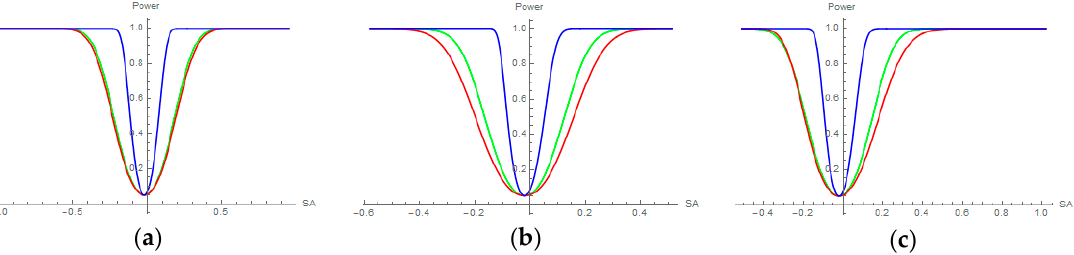
Figure A11. Statistical power curves for the MC (green), the GR (red), and the SAR ρ (blue): ( a ) the 7-by-7 square tessellation, rook adjacency case; ( b ) the 7-by-7 square tessellation, queen adjacency case; and, ( c ) the 7-by-7 hexagonal tessellation case.